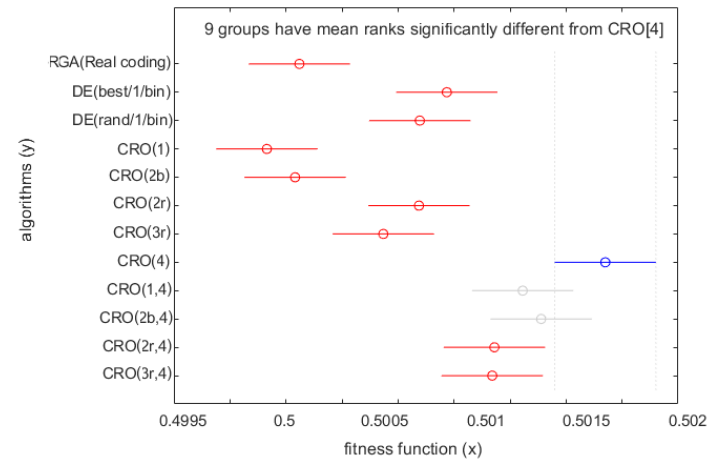
Figure 22. Tukey test results obtained from 30 runs of the algorithm.